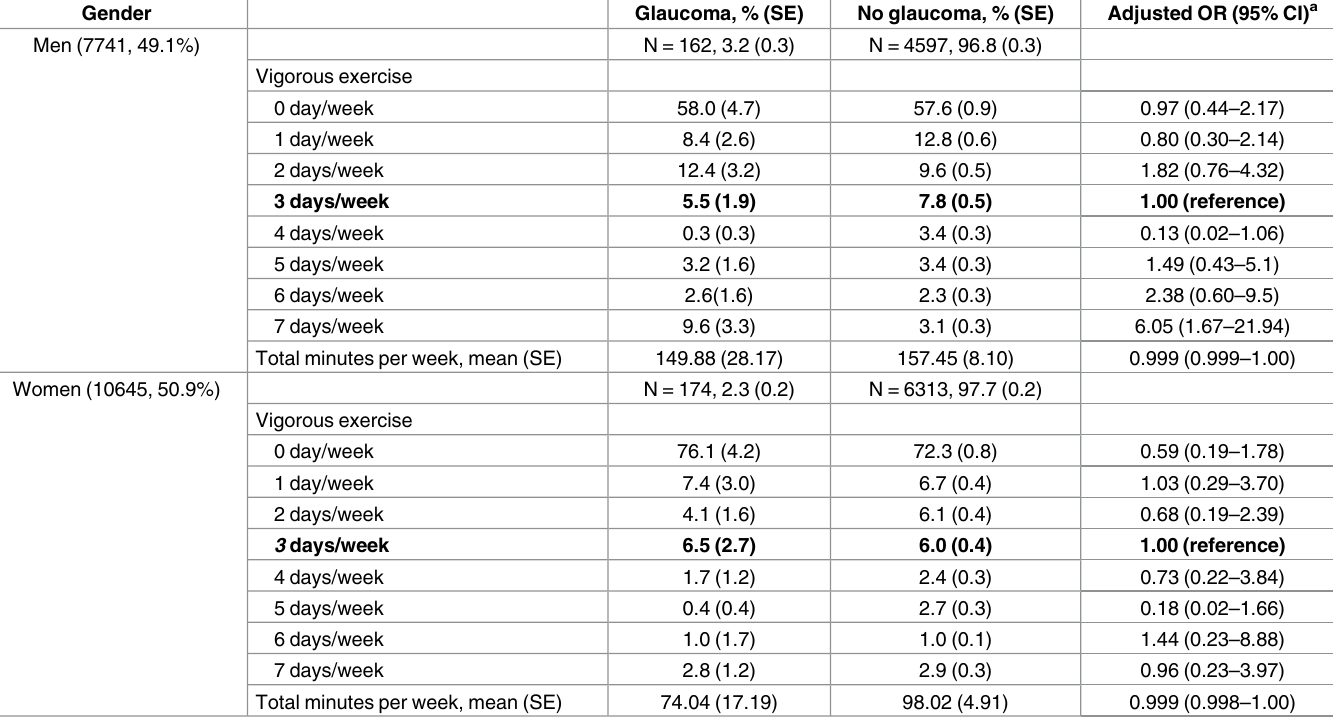
Table 6. Association between frequency of doing vigorous exerciseand glaucoma in men and women. Gender Glaucoma, % (SE) No glaucoma, % (SE) Adjusted OR (95% CI) a Men (7741,